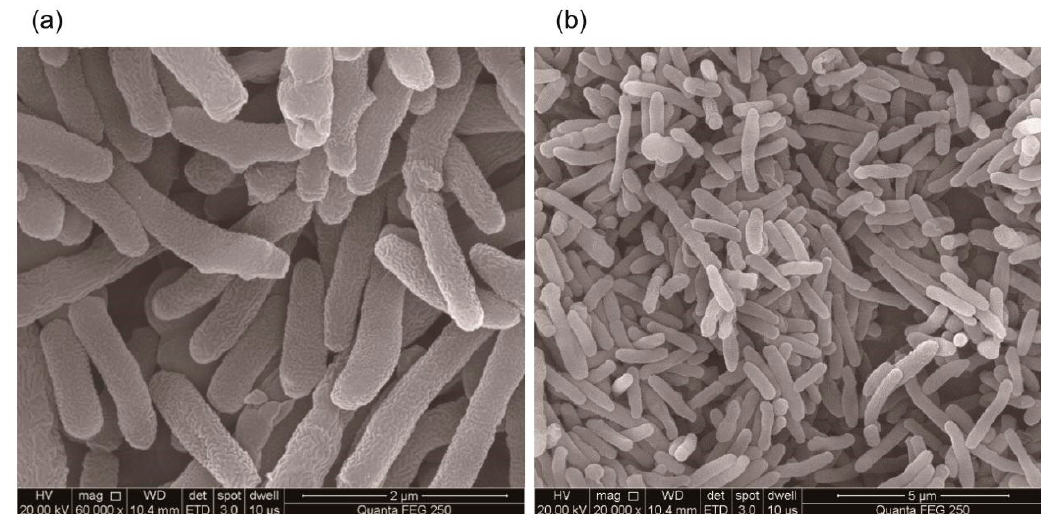
Figure 2. Scanning electron micrographs of strain Lysinibacillus pakistanensis LZH-9: ( a ) with magnification of 60,000; and ( b ) with magnification of 20,000. Table 1. Based on 16S rRNA and chemical oxygen demand (COD) removal efficiency of four halotolerant bacteria.